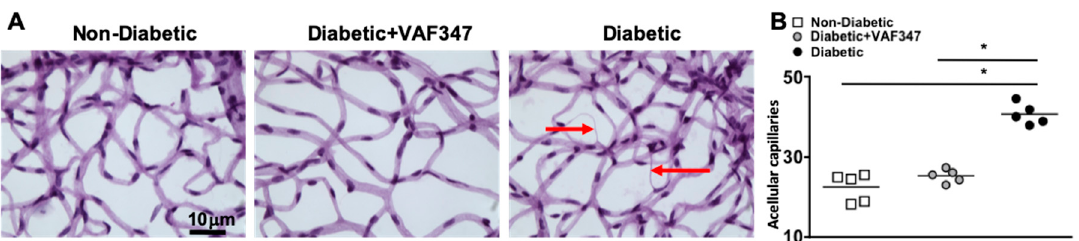
Figure 4. Capillary degeneration in the retinas of STZ-diabetic mice. ( A ) Representative images of acellular capillaries and degeneration in retinal capillary beds of non-diabetic, VAF347-treated STZ-diabetic, and untreated STZ-diabetic C57BL/6 mice (scale bars of all images = 10 μ m). Red arrows highlight acellular capillaries. ( B ) Quantification of acellular capillaries within a 1.10 mm 2 area of each retina in non-diabetic (white square), VAF347-treated STZ-diabetic (grey circle), and untreated STZ-diabetic (black circle) C57BL/6 mice. Each data point represents an individual retina from five different mice. p -value was first equated by two-way ANOVA analysis and then an unpaired t -test with Tukey’s post-hoc analysis, wherein * = p < 0.01. All samples were collected eight months after diabetic conditions were confirmed.